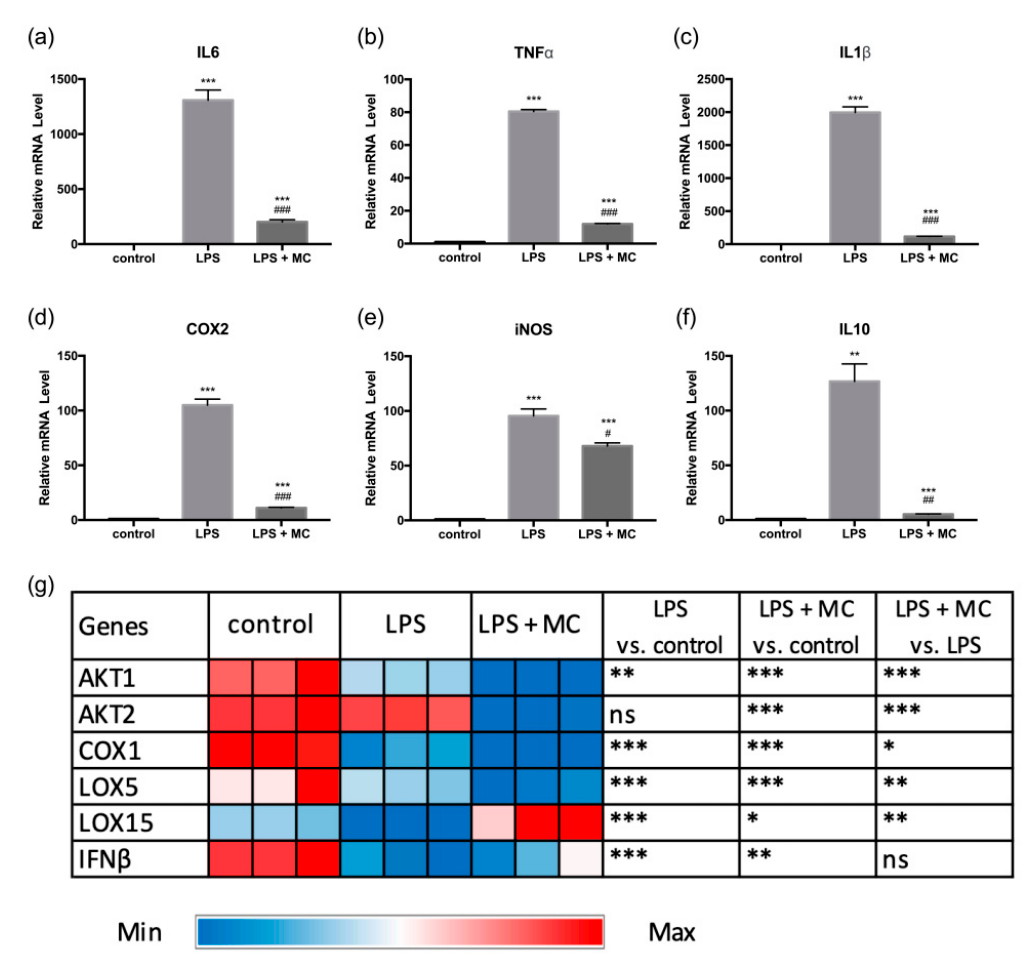
Figure 1. Effect of lipopolysaccharide (LPS) and Momordica charantia (MC) treatment on the expression of inflammatory genes: ( a ) IL6 , ( b ) TNF- α , ( c ) IL1 β , ( d ) COX2 , ( e ) iNOS , and ( f ) IL10 . ( g ) Heatmap showing the expression of six selected genes including AKT1 , AKT2 , COX1 , LOX5 , LOX15 , and IFN β . The RAW264.7 macrophages were pre-treated with MC water extract for four hours at the concentration of 12.5% v / v (equivalent to 5 mg/mL soluble MC extract), followed by incubation with 1 μ g/mL LPS for four hours. The control group was treated with an equal volume of MiliQ water for a similar incubation time. For ( a – f ), the qRT-PCR data are expressed as mean ± SEM. Group comparison was performed using the Student’s t -test. For ( a – f ), ** p < 0.01, *** p < 0.001 compared with the control group; # p < 0.05, ## p < 0.01, ### p < 0.001 compared with the LPS group. For ( g ), * p < 0.05, ** p < 0.01, *** p < 0.001; ns: no significant difference between groups.